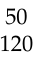
Table 1. Cross-linked enzyme aggregate (CLEA) preparation